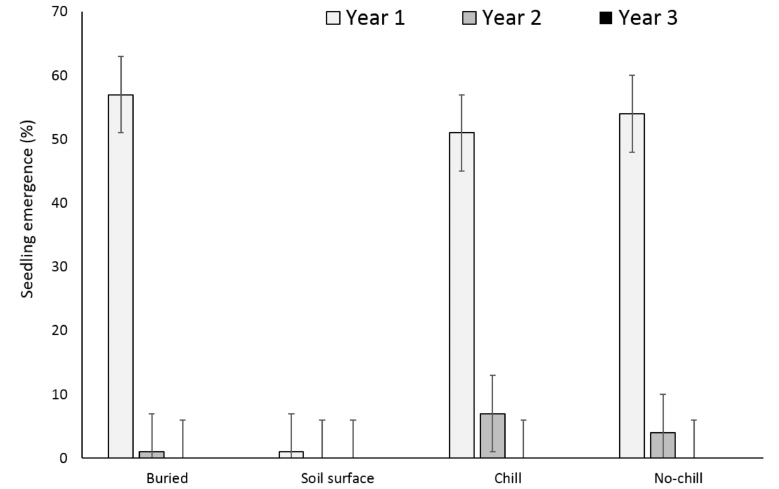
Figure 1. Effect of environmental conditions on X. strumarium emergence originating from a single maternal source. Vertical bars represent least significant difference (LSD) at 5% significance level.